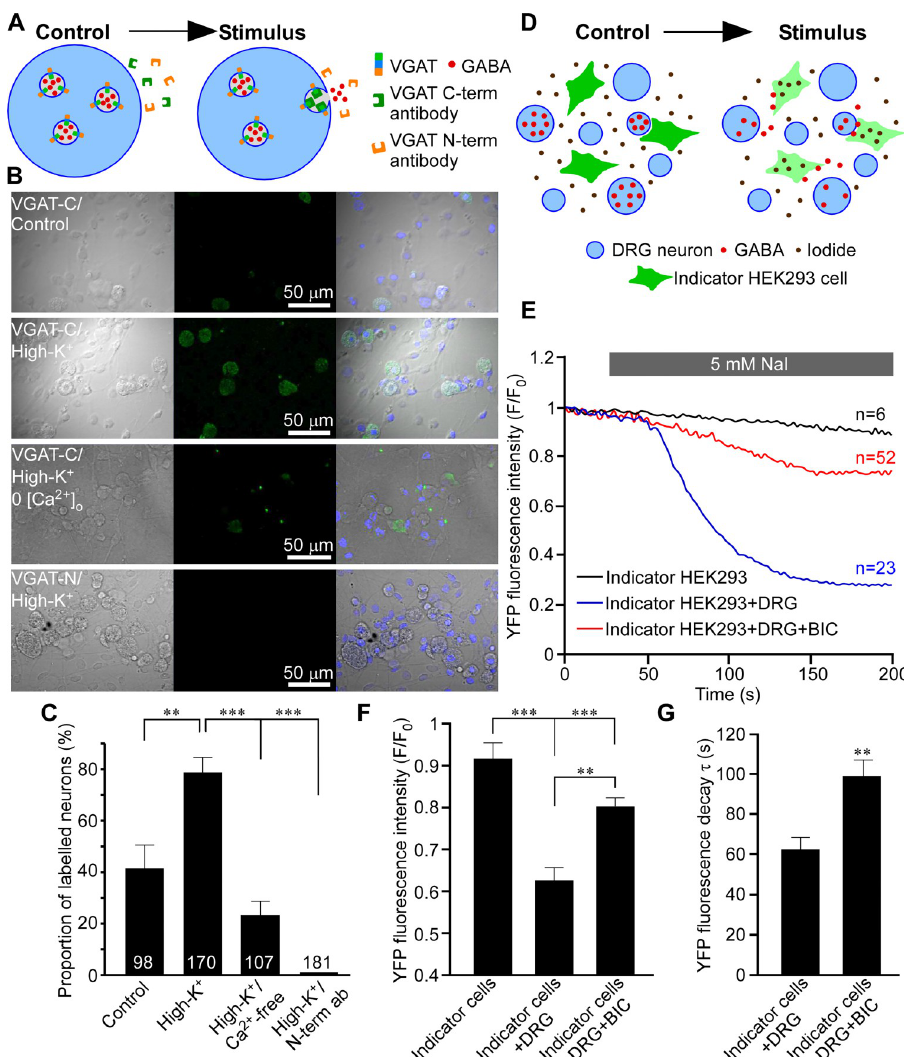
Fig 7. Activity-dependent and spontaneous release of GABA from DRG neurons. ( A–C ) Vesicular GABA release from DRG neurons studied with luminal VGAT antibody uptake. ( A ) Schematic of activity-dependent uptake of luminal (C-terminal) VGAT antibody. ( B ) Bright-field (left), fluorescence (middle), and overlaid images of DRG culture incubated in the presence of either a luminal VGAT antibody (C-term; 3 upper rows) or a cytoplasmic (N- term; bottom row) antibody. Cells were incubated in the control extracellular solution (upper row) or depolarized by extracellular solution containing 100 mM KCl (second from the top and the bottom rows). In the second from the bottom row, Ca 2+ was excluded from the extracellular solution. ( C ) Summary of experiments like these shown in B ( N = 3–5, number of neurons is indicated within the columns); quantified is the percentage of stained neurons �� p < 0.01, ��� p < 0.01 (Fisher’s exact test with Bonferroni correction). ( D–G ) GABA release from DRG investigated with the use of indicator HEK293 cells. ( D ) Schematic of the experiment: HEK293 cells transfected with α 1, β 2, and γ 2 subunits of GABA A receptors and a halide-sensitive EYFP mutant (H148Q/I152L; EYFP-QL) are co-cultured with DRG neurons and imaged in the presence of 5 mM extracellular iodide. When GABA is present in the extracellular solution, GABA A channel opening causes I - influx and EYFP-QL fluorescence quenching. ( E ) Application of NaI induced bicuculline-sensitive EYFP-QL quenching only when indicator HEK293 cells are co-cultured with DRG but not in monoculture; representative traces are shown for each experimental condition. ( F ) Summary for panel E; normalized fluorescence intensity is quantified at 200 s of each recording. Kruskal–Wallis ANOVA: H(2) = 33.6, p < 0.001; Mann–Whitney post hoc test: significant difference between indicated groups, �� p < 0.01, ��� p < 0.001. ( G ) Quantification of the kinetics of the EYFP-QL fluorescence quenching in experiments shown in E; individual recordings were fit with exponential function and time constants ( τ ) of the fluorescence decay were analyzed. Mann– Whitney test: U = 786, p < 0.01. In E and F, data from 3 independent experiments for each condition are shown, number of cells analyzed is indicated above each trace in panel E. Metadata for quantifications presented in this